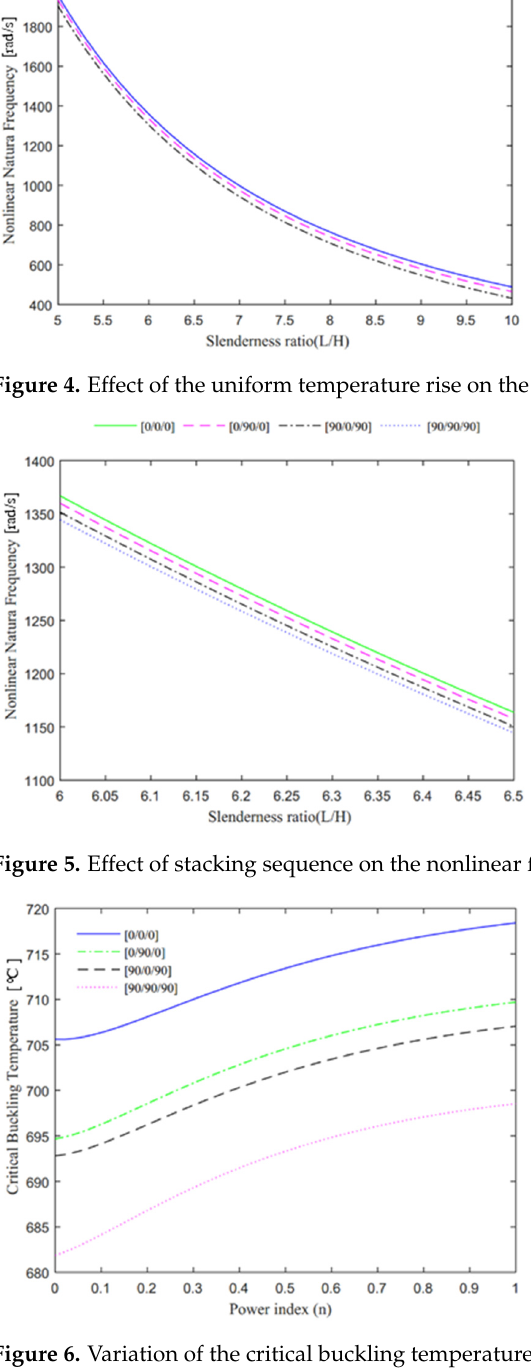
Figure 6. Variation of the critical buckling temperature versus power index.